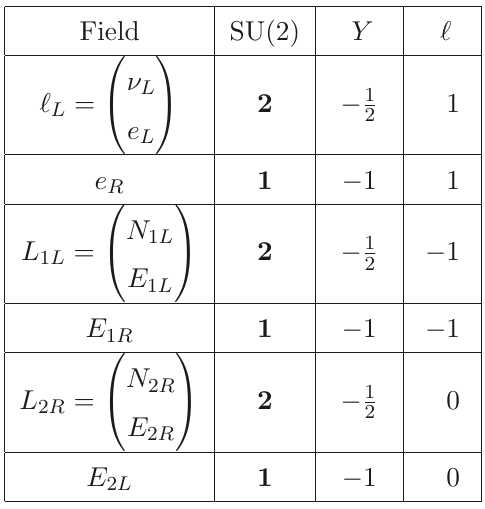
Table 1 . Lepton fields for anomalies free